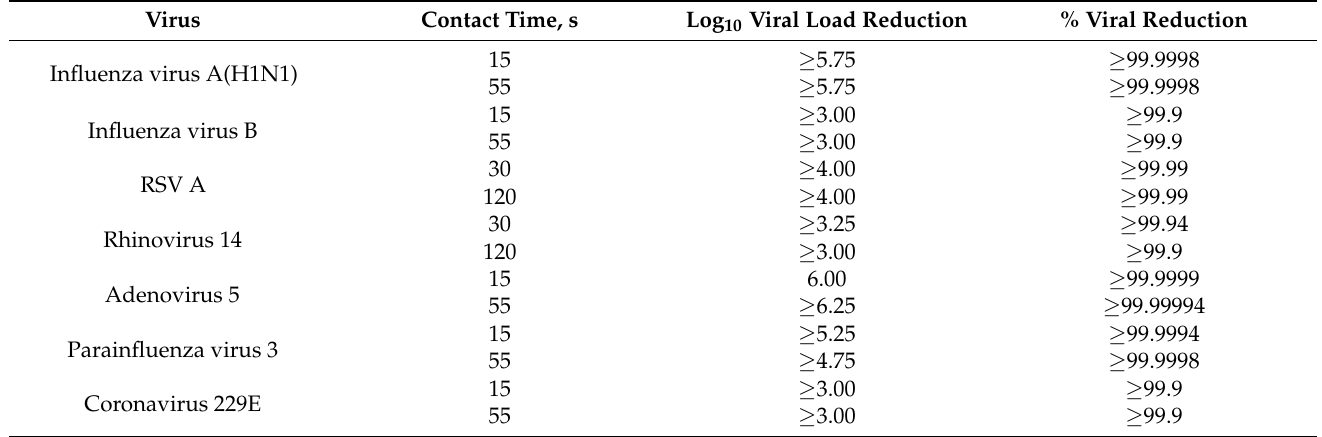
Table 3. Virucidal activity of Sentinox, by virus and contact